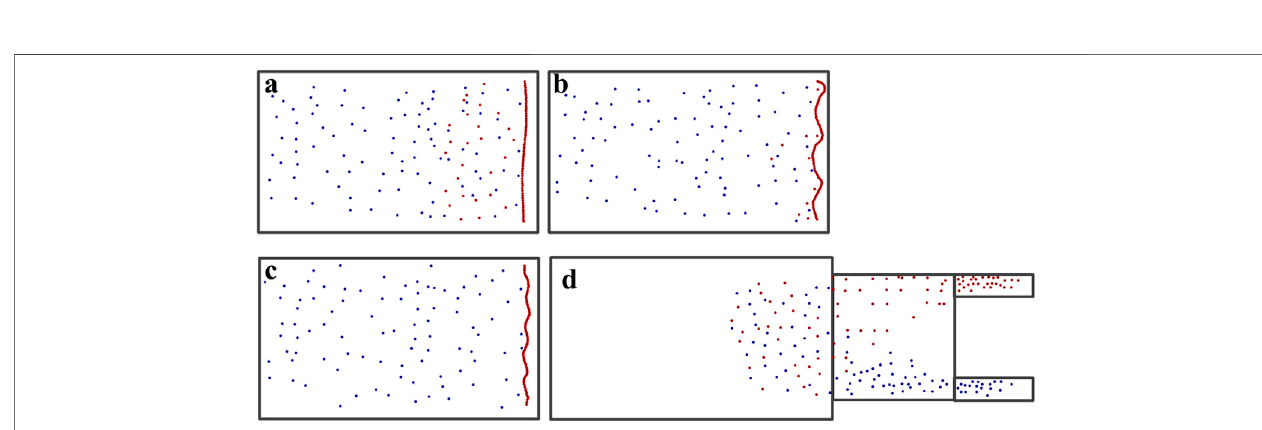
FIGURE 2 | Particles with a higher refractive index (red spheres) and lower refractive index (blue spheres) are sorted by the optical sorting platform. A linear OV beam (A) without kinks (see Supplementary Movie S1 ), (B) with kinks corresponding to a triangle (see Supplementary Movie S2 ), and (C) with kinks corresponding to a pentagon (see Supplementary Movie S3 ). (D) Optical lattice (see Supplementary Movie S4